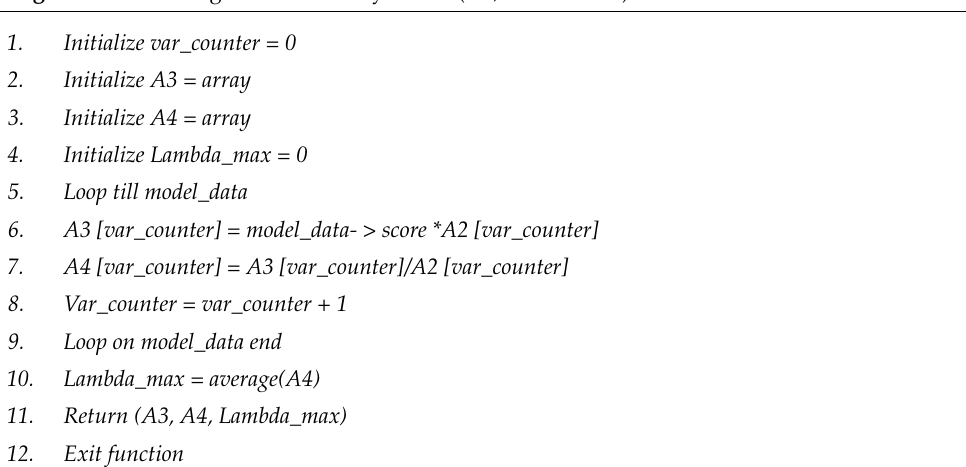
Table 4. Calculating consistency ratios. Algorithm 2: Finding the Consistency Ratios (A2, Model